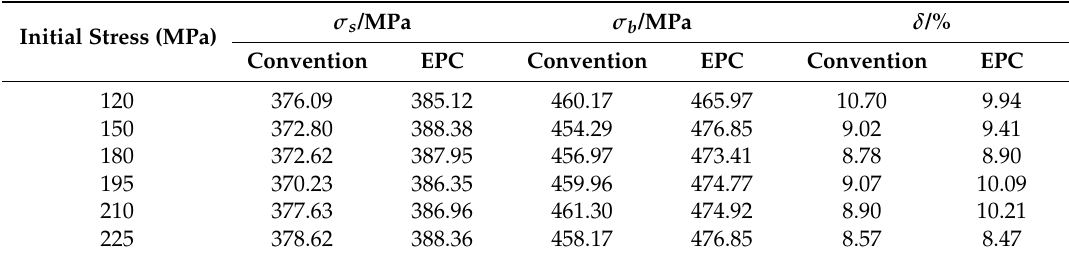
Table 2. Comparison of properties after stress relaxation with and without EPC under different initial